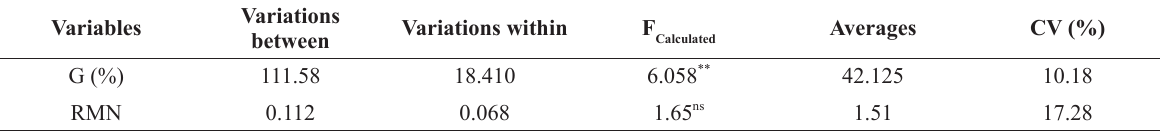
Analysis of variance of percentage of germination (G) and root mean number (RMN) for somatic embryos of C. papaya L. ‘Golden THB’, on germination medium with different concentrations of